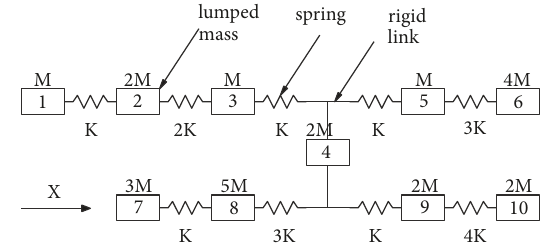
Figure 1: Undamped lumped parameter mass model, only the horizontal dynamics are considered, the global DOFs are labeled in the box, the spring rate K=1E4 N/m, and the unit mass M=1 kg.